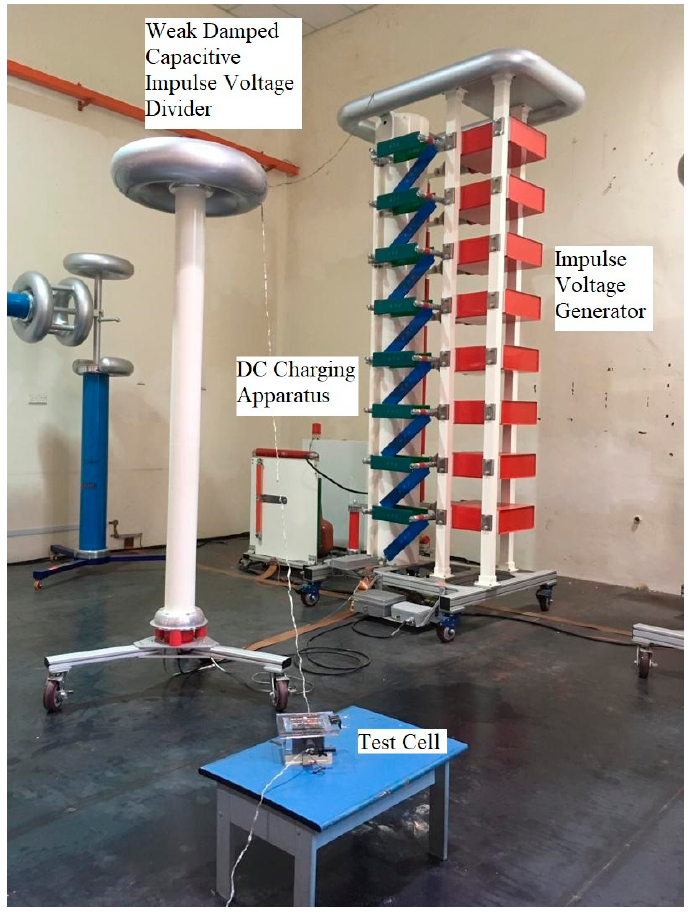
Figure 7. Lightning impulse laboratory setup.